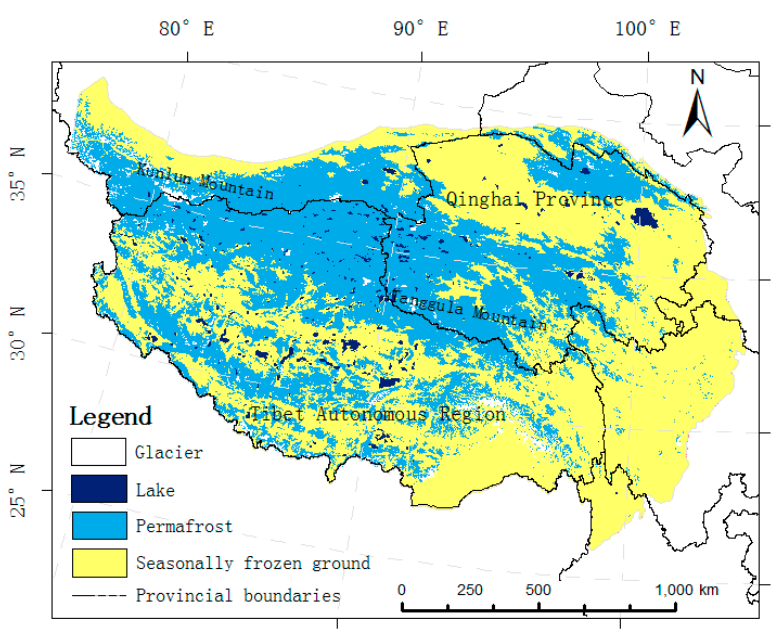
Figure 8. Permafrost map of QTP based on multi-source remote sensing data.